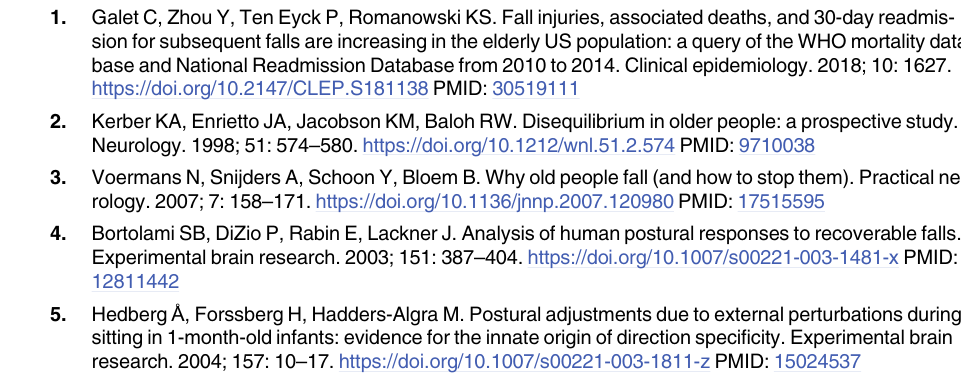
Fig 5. Vector analysis of perturbation. (A) Sample of a typical subject. From right to left: Thirty seconds of unperturbed COP, COP perturbation without vectors (For clarity), which took about 300 seconds, COP perturbation with vectors overlayed (same as the middle graph). (B) Vector analysis results for all subjects is shown in this graph. The shaded area represents the SD of each perturbation direction with vectors representing the direction and amplitude of perturbation. (C) Same as in figure B but instead of vectors, actual points are plotted. The five trials for each stimulation direction (left, right, both) were averaged for each subject to represent the response profile of that subject. These average points are plotted for all 15 subjects. There are, therefore, 45 points for each direction. A line connecting the center (0,0) to each point would constitute its vector.